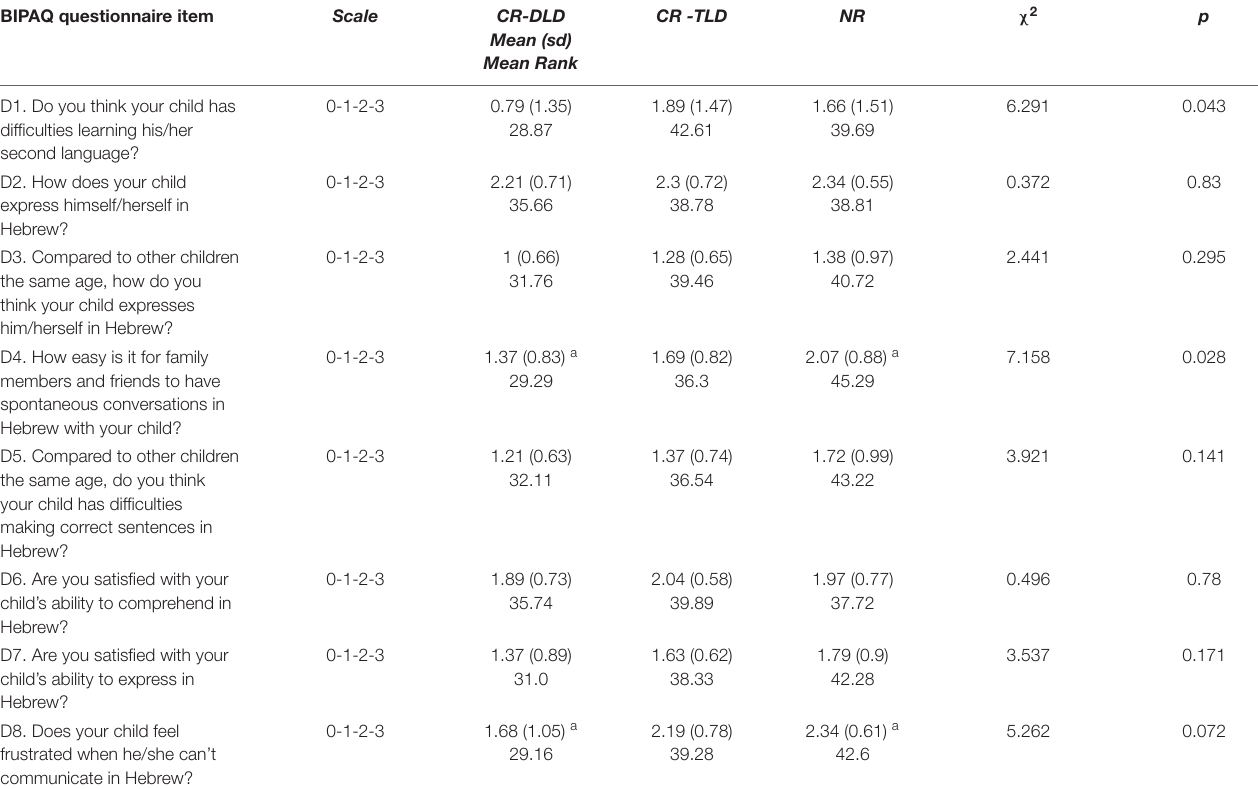
TABLE 5 | Questions Section D: SL-Hebrew Language